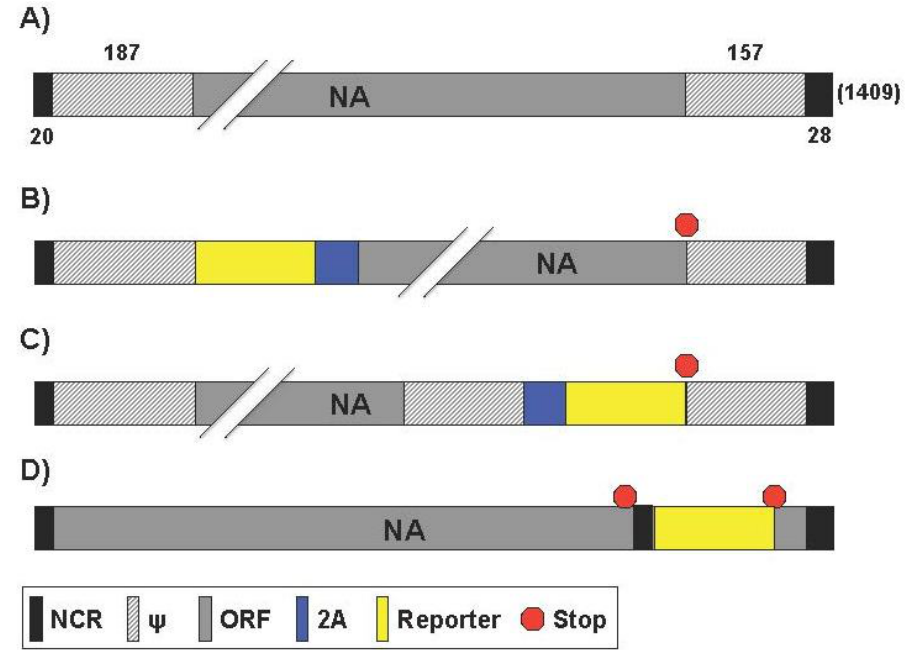
Figure 5. NA reporter influenza A viruses: Schematic representation of the NA segment from WT ( A ) and reporter ( B – D ) influenza A viruses as described in Figure 1. Nucleotide lengths for the NCR, ψ , and NA segment are indicated; ( B , C ) Bicistronic transcription of NA and reporter gene: Insertion